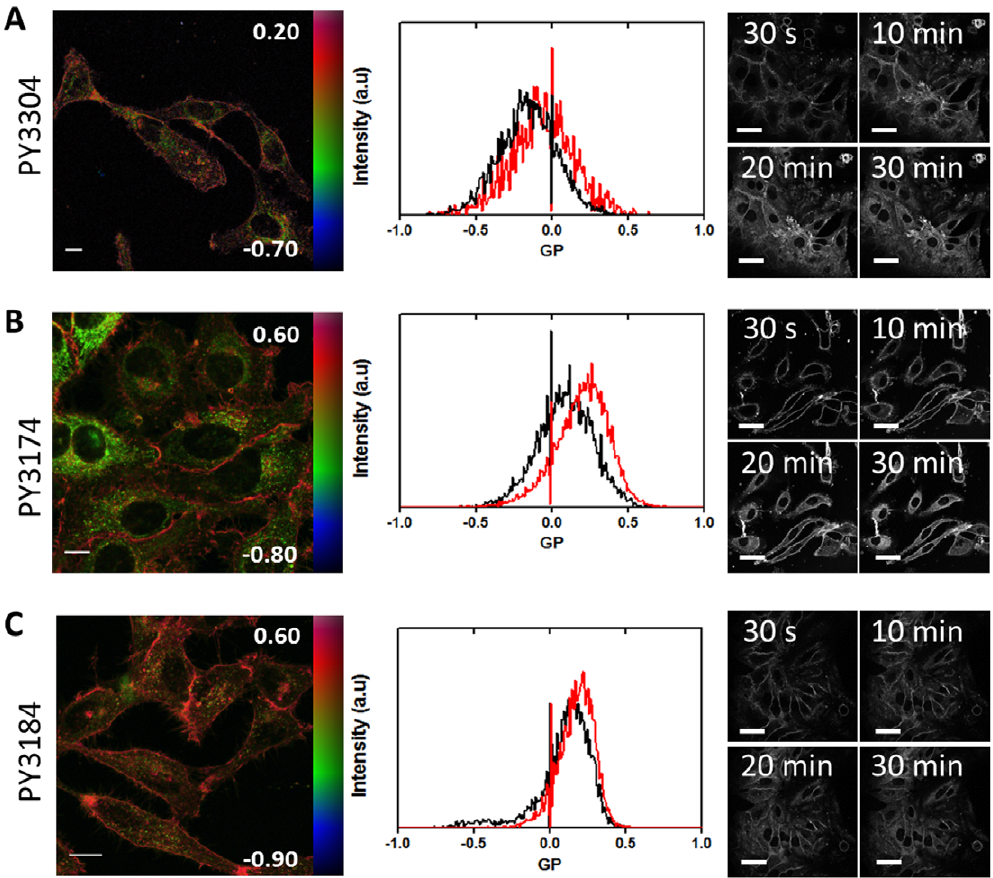
Figure 4. Analysis of live HeLa cells. Left: GP images of live HeLa cells stained with PY3304 (A), PY3174 (B), PY3184 (C). GP images are in false color and run over the range indicated by the color bars to indicate a higher degree of membrane order (predominately colored red) in the plasma membrane compared to intracellular membranes (predominately colored green). Scale bars 10 m m. Middle: Histograms of the GP values obtained from GP images of live HeLa cells stained with PY3304 (A), PY3174 (B), PY3184 (C). Histograms obtained from ROIs for plasma membrane (red line) and intracellular membranes (black) were normalized to the total number of pixels. Right: Staining profile of Live HeLa cells. HeLa cells were incubated with PY3304 (A), PY3174 (B) and PY3184 (C) for 30 min. Confocal intensity images were acquired at 30 s, 10 min, 20 min, and 30 min after dyes were added. Images show complete staining of all cellular membranes after 30 min. Scale bars 50 m m.